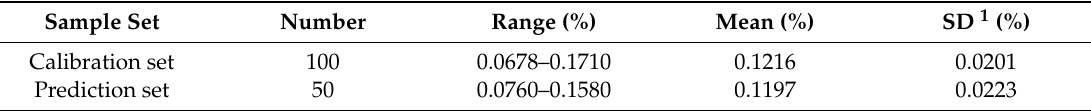
Table 1. Reference values of total nitrogen (TN) content in the 150 soil